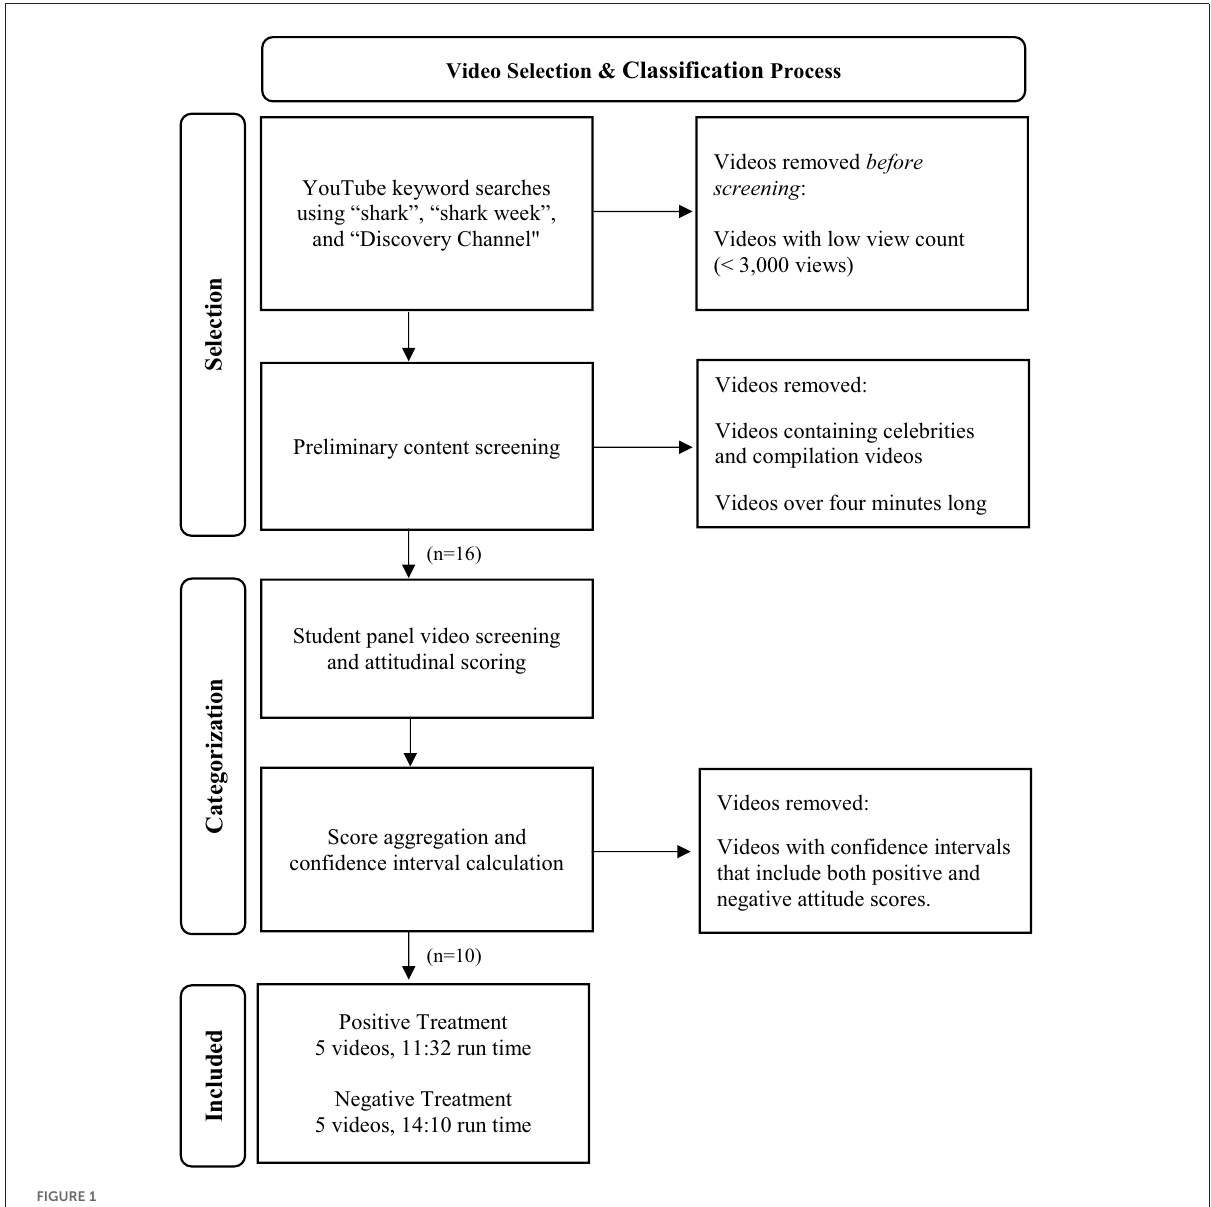
FIGURE1 Video selection process for the positive and negative video